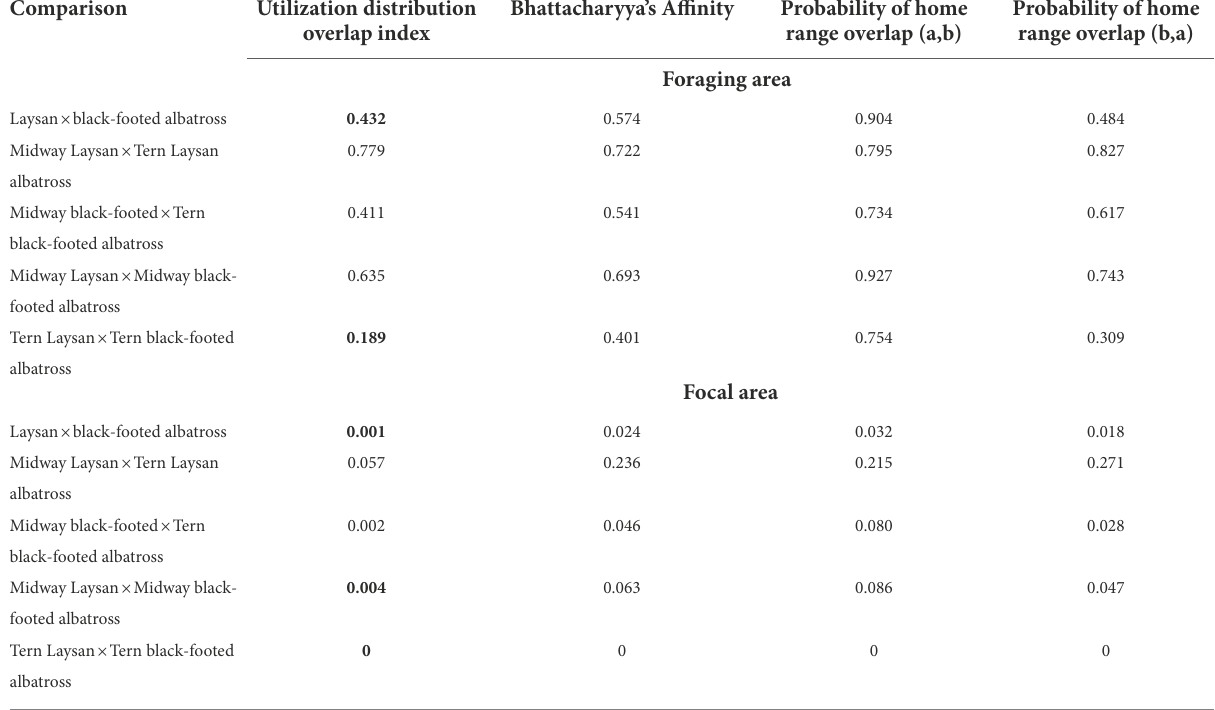
TABLE 4 Values of overlap indices for Laysan and Black-footed albatross breeding at Midway and Tern Island for all post-breeding points.